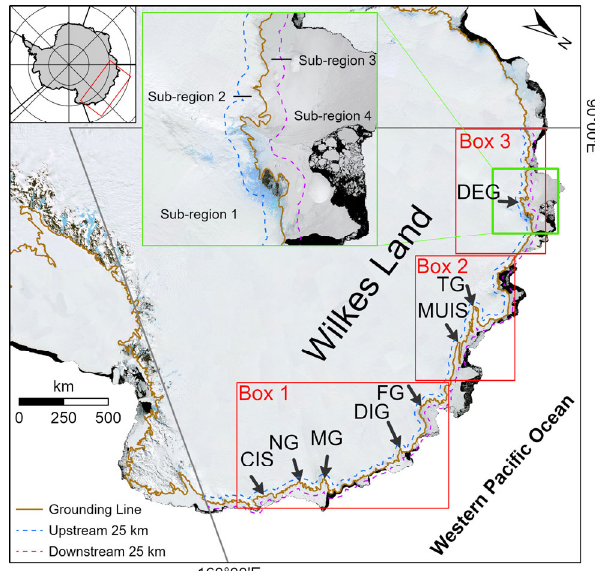
Figure 1 . The location of the Western Pacific Ocean sector region of East Antarctica. The background is the LIMA mosaic (Bindschadler et al., 2008). The brown line is the grounding line (GL) (Gardner et al., 2018). DEG denotes the Denman Glacier, TG the Totten Glacier, MUIS the Moscow University Ice shelf, FG the Frost Glacier, DIG the Dibble Glacier, MG the Mertz Glacier, NG the Ninnis Glacier, CIS the Cook Ice Shelf. The red boxes represent the three regions of Figure 2. The inset is an enlarged view of the green box, displaying an example of sub- regions 1-4 to reveal the spatial distribution of the corrected values.